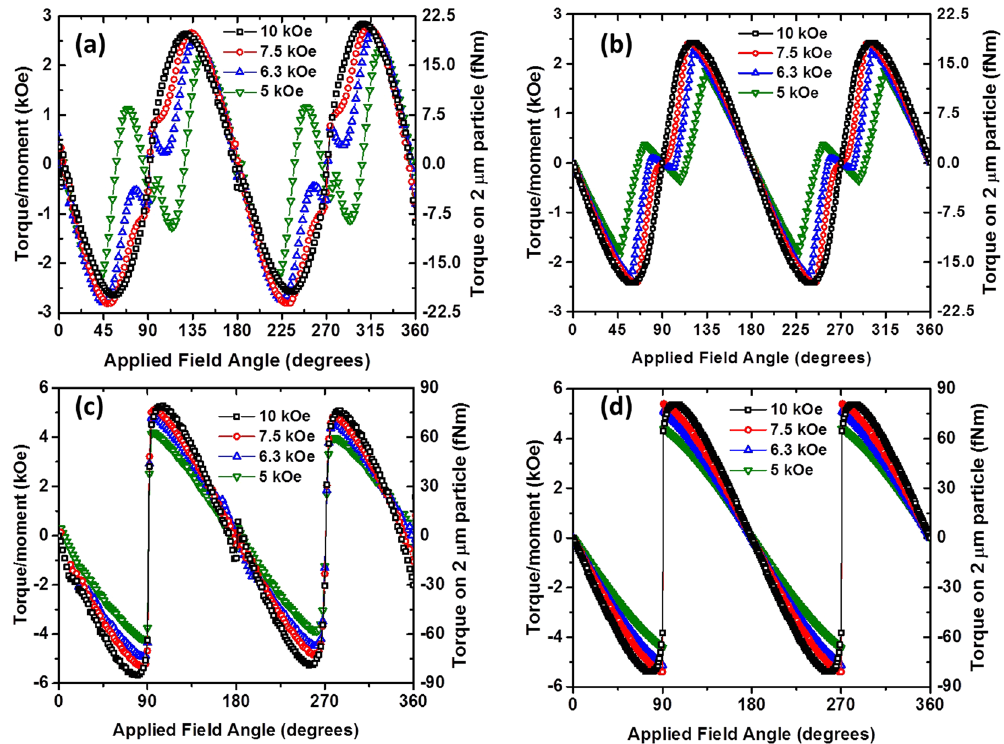
Figure 4. ( a ) Calculated torque per unit moment from anomalous Hall effect measurements as a function of applied field and angle for a CoFeB/Pt thin film. The right hand axis gives the torque assuming the moment of a 2 micron diameter particle. ( b ) Simulated torque per unit moment using the magnetic characteristics of the sample measured ( a ). ( c ) Calculated torque per unit moment from anomalous magnetoresistance measurements as a function of applied field and angle for a Py thin film. ( d ) Simulated torque per unit moment using the magnetic characteristics of the sample measured in ( c